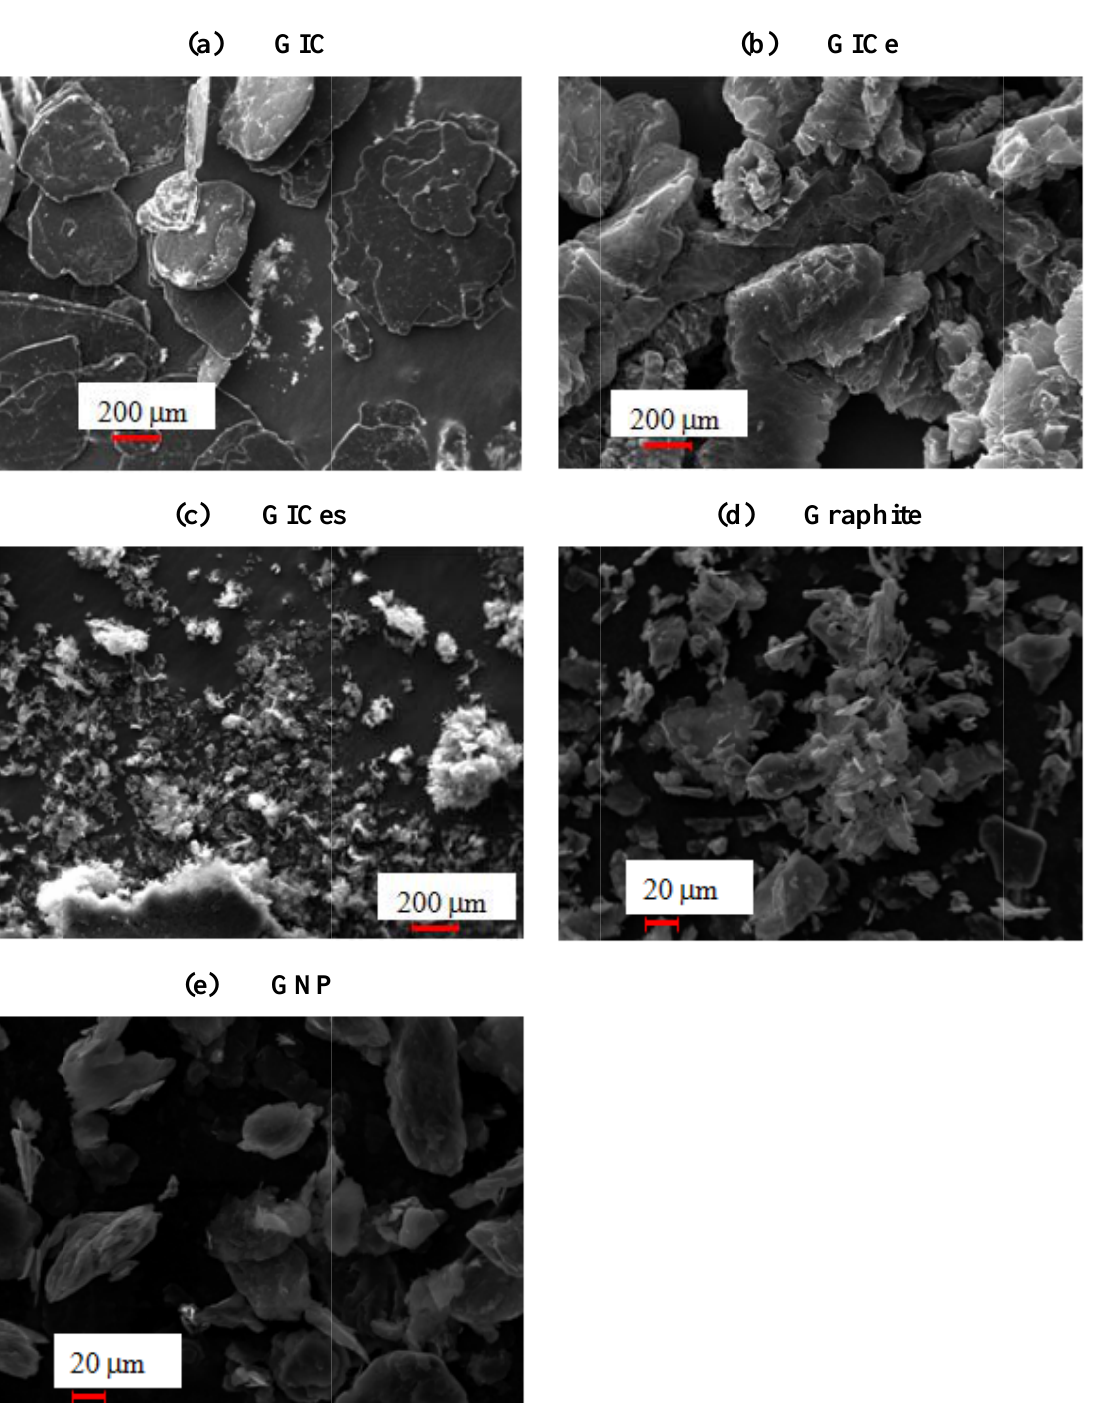
Figure 3. Th characteristi The GIC one